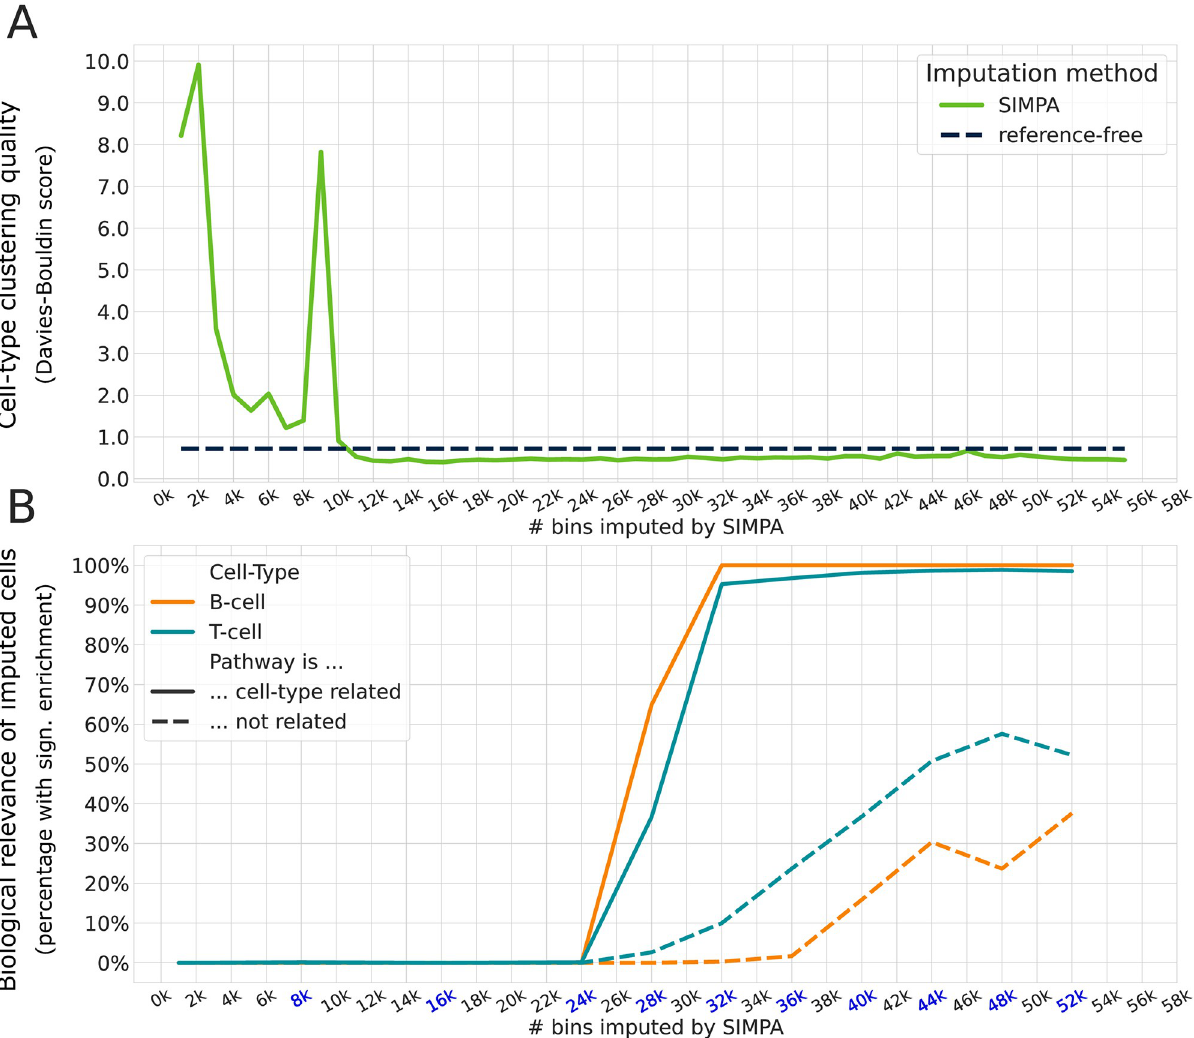
Fig 6. Clustering quality and pathway enrichment for different sizes. A . Clustering quality (y-axis) evaluated with the Davies-Bouldin score (the lower the better) applied on the imputed data after dimensionality reduction as described for Fig 5A+5B. While the reference-free method derived only one imputed set for all the single cells (dashed black line), we could derive several imputed sets of different sizes using the imputed probabilities from SIMPA (x-axis). B . The pathways under investigation are the B-cell and T-cell receptor signaling pathways. In this way we analyze two pathways surely related or unrelated with the cell-types present in the dataset, B-cell and T-cell. The y-axis describes the percentage of imputed profiles for which a significant enrichment of the aforementioned pathways could be achieved. The dashed lines represent cases for which the unrelated pathway is significantly enriched, which is the T-cell receptor signaling pathway when analyzing a B-cell and vice versa. The significance level used is 0.001 similar to the analysis shown in Fig 5C. To reduce the computational resources spent on the pathway enrichment, this was done for ten imputation set sizes (highlighted in blue on the